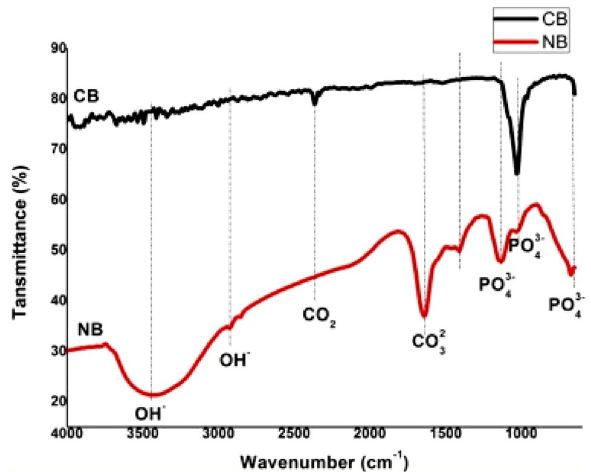
Fig. 12 FT-IR spectra for CB and NB derived hydroxyapatites [45]